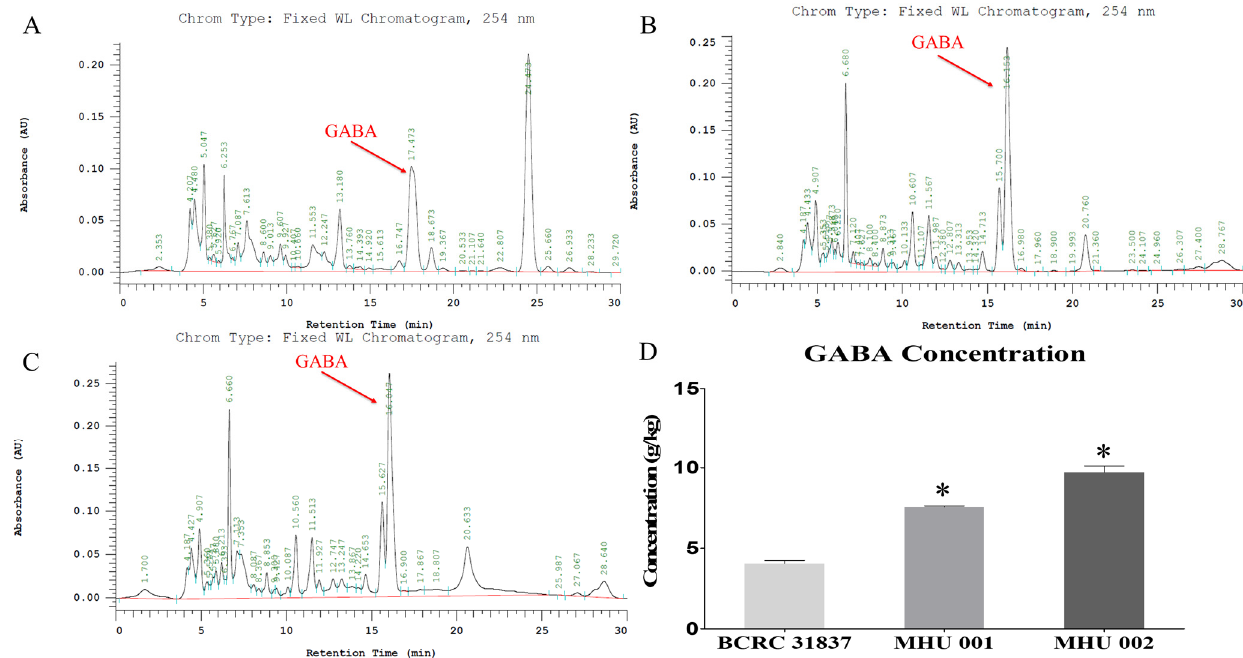
Figure 1. The elution profile of GABA present in tempeh and derivates by high performance liquid chromatography (HPLC) with a C-18 reverse-phase column. Tempeh was fermented by different strains of R. oryzae , i.e., BCRC 31837 ( A ), MHU 001 ( B ), and MHU 002 ( C ). GABA concentration of three different kinds of tempeh ( D ). The asterisk indicates a statistically significant difference between the control and the tempeh groups. Bars, means of triplicates ± S.D. (*) p < 0.001, as compared with the relative control group by one-way ANOVA.